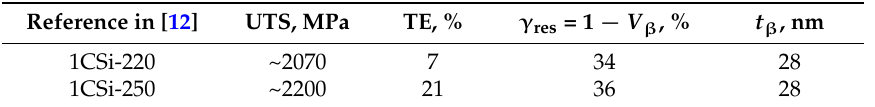
Table 1. Tensile elongation for an identical material (1C-2.5Si wt %) transformed at 220 or 250 ◦ C, after [12].